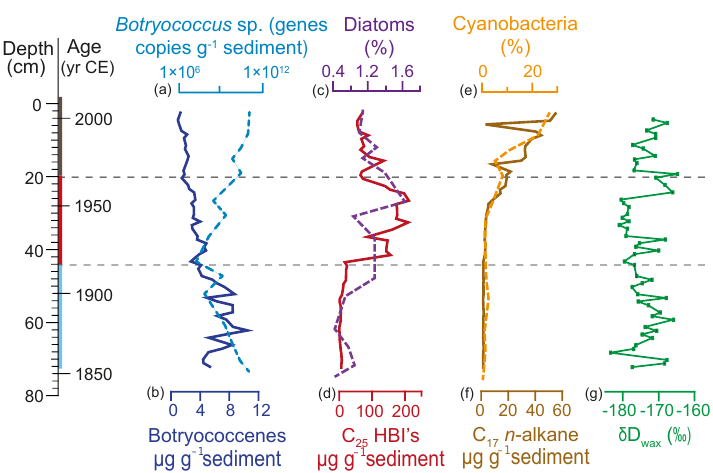
Figure 4. Depth and age profiles of: (a) Botryococcus sp. (18s rRNA genes copies g − 1 sediment) (blue dashed), (b) botryococcenes, a proxy for Botryococcus braunii (B race) (blue solid), (c) diatoms (%) (purple dashed), (d) C 25 Highly branched Isoprenoid (HBIs), a proxy for diatoms (red solid), (e) cyanobacteria (%) (mustard dashed), (f) C 17 n -alkane, a proxy for cyanobacteria (brown solid) and (g) δD values of C 27 − 29 − 31 n -alkanes ( δD wax ) , a proxy for rainfall amount (green). The black dashed lines represent the transitions between the different units. For interpretation of the references to colour, the reader is referred to the web version of this